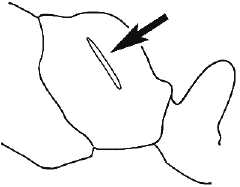
– Spiracle not as above, generally situated on declivitous face of propodeum; mandible and mandibular teeth not modified as above, teeth